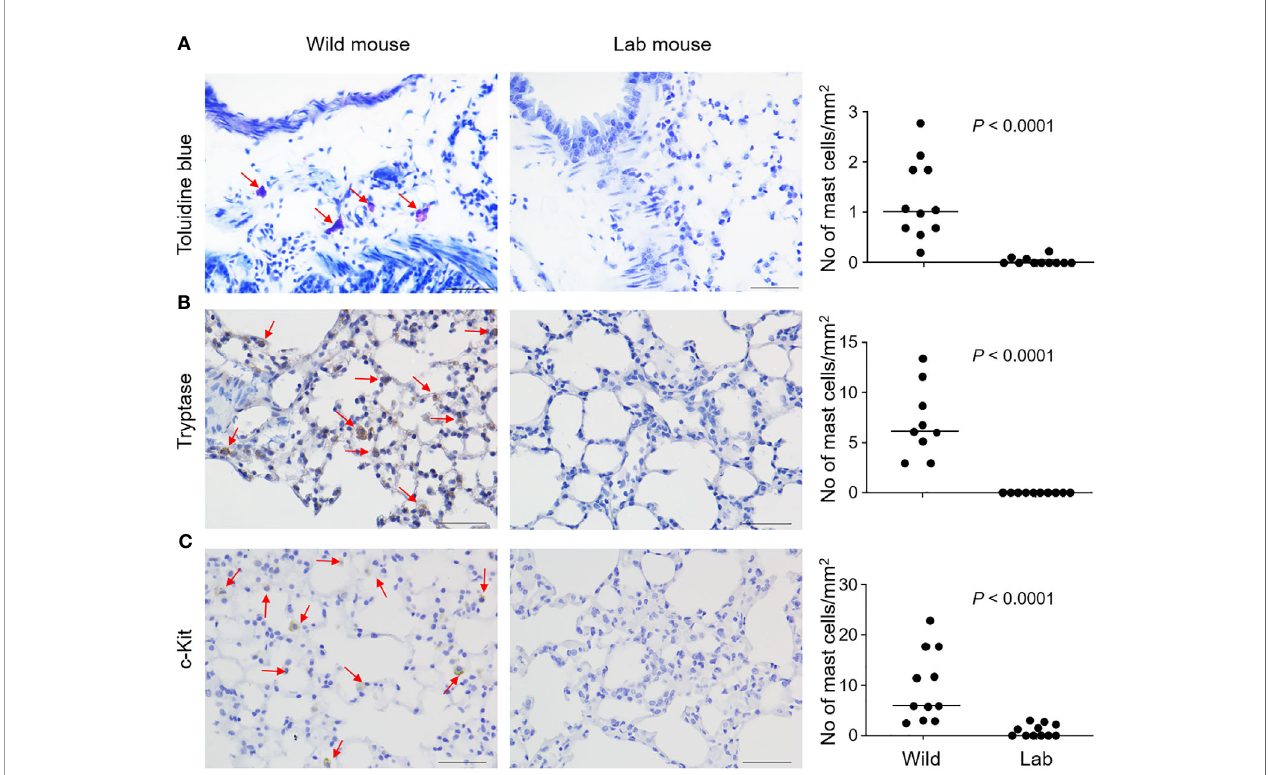
FIGURE 1 | Mast cells are identi fi ed in the lung parenchyma of wild free-living mice. Free-living wild mice were trapped at Hemtabad, India ( n = 11). Their lung tissues, together with those from C57BL/6 laboratory (lab) mice ( n = 11), were processed and sectioned, followed by staining with the mast cell-speci fi c dye toluidine blue (A) , or peroxidase-based immunostaining using an anti-mouse tryptase antibody (B) or an anti-mouse c-Kit antibody (C) . Arrows indicate mast cells which were stained purple (for toluidine blue) or brown (for immunostaining). Mast cell density was quanti fi ed and shown as number of cells per unit area (right panels). Each dot represents an individual mouse and horizontal lines indicate the median. Scale bar: 50 m m. Two wild mice and one lab mouse, which had extremely high values were removed ( B , right panel) as outliers based on Grubbs ’ test ( P <